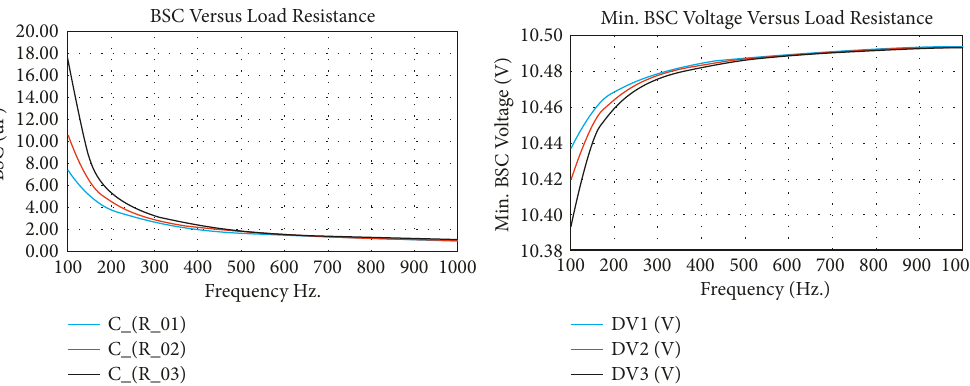
Figure 8: Variation of the BSC and minimum voltage with frequency at different load resistances.